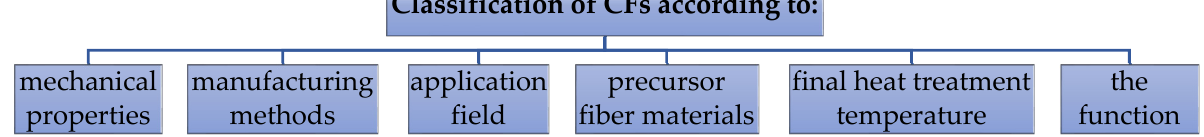
Figure 3. Classification of common carbon fibers according to specific features.